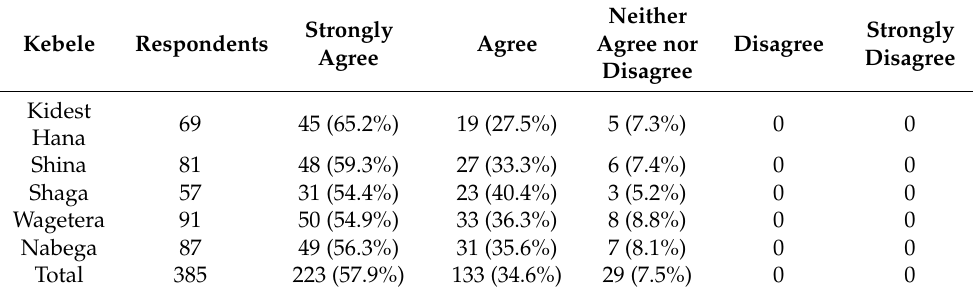
Table 9. Farmers’ perception on the effects of the rice market on wetland resources.